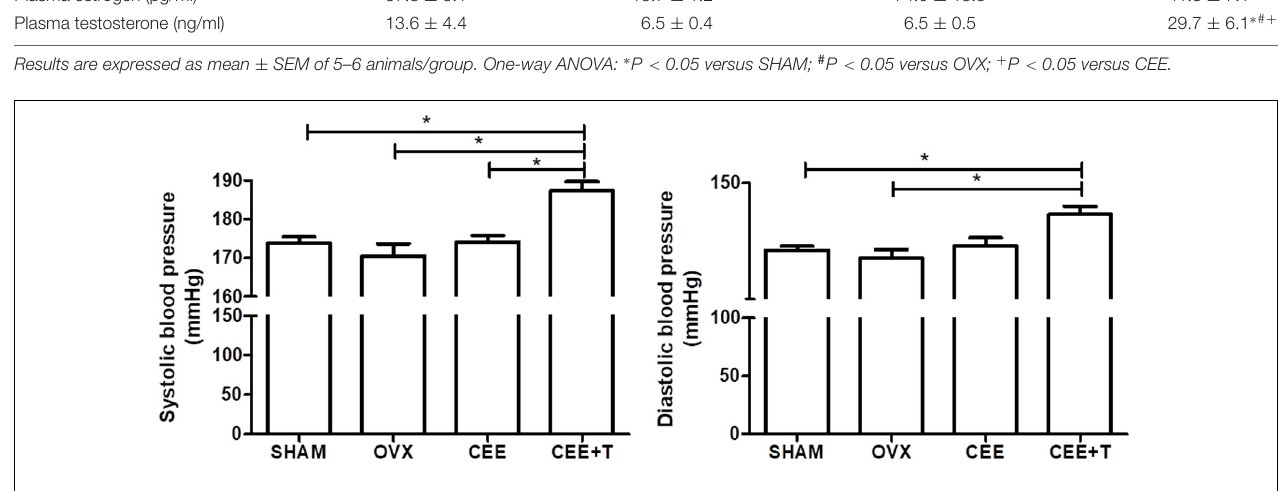
FIGURE 1 | Systolic and diastolic arterial blood pressure (mmHg) were obtained from SHAM, ovariectomized (OVX), OVX treated with conjugated equine estrogens (CEE) and OVX treated with CEE plus testosterone (CEE+T) female spontaneously hypertensive rats. Results represent the mean ± SEM from 6 to 8 animals/group. One-way ANOVA: ∗ P <